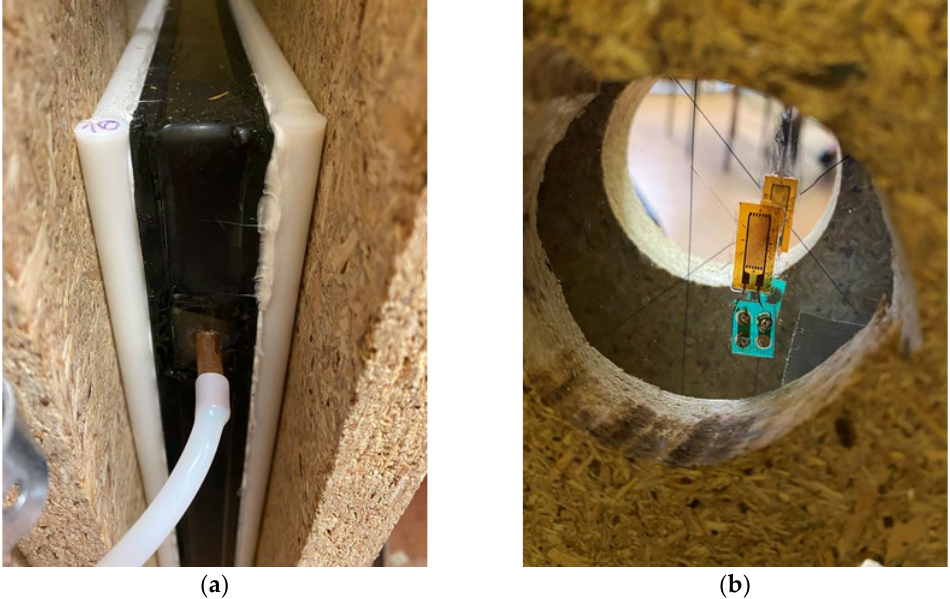
Figure 1. Details of the test stand: ( a ) mechanical supports and silicone conduits for gas exchange in the gap; ( b ) strain gauges mounted to the panes.